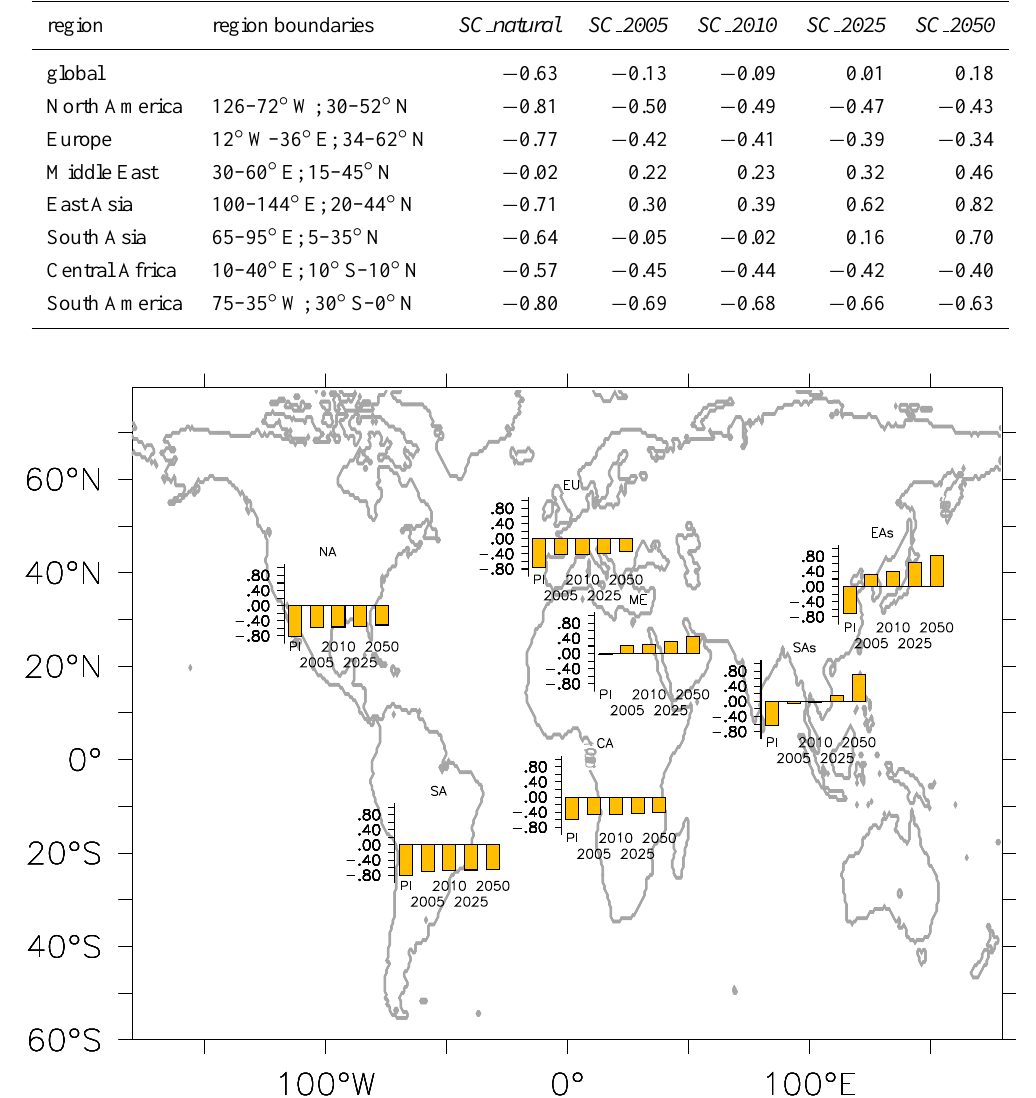
Fig. 13. Population Weighted Multi Pollutant Index (PW-MPI) values for different regions. This figure summarises Table 5. The regions are: North America (NA), South America (SA), Europe (EU), Middle East (ME), Central Africa (CE), South Asia (SAs) and East Asia (EAs).